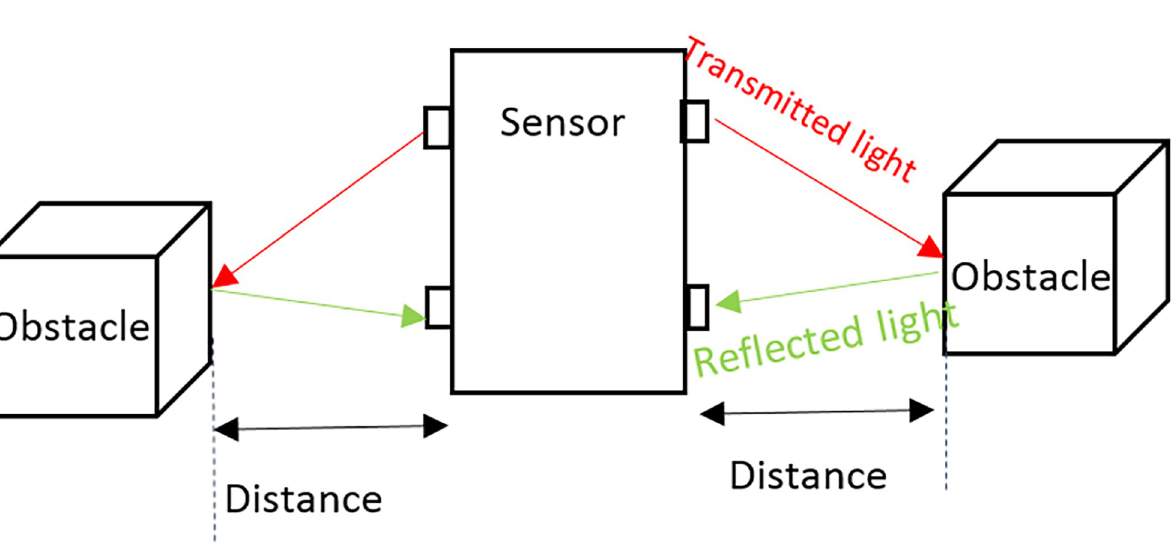
Fig 16. TOF operating